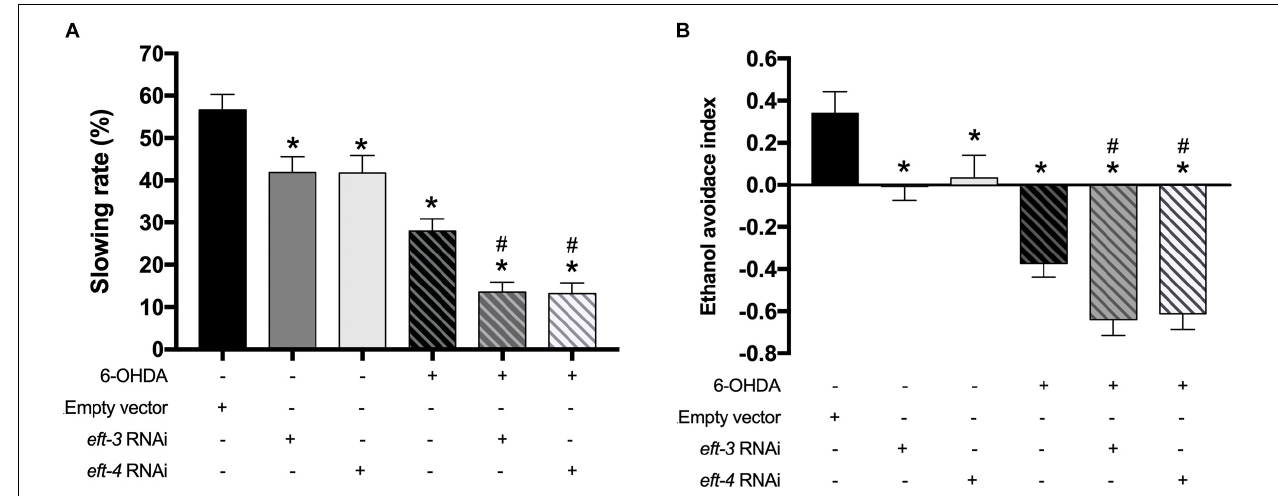
FIGURE 3 | Effects of eft-3 / eft-4 RNA interference (RNAi) and/or 6-hydroxydopamine (6-OHDA) exposure on dopamine-dependent behaviors. (A) Graphical representation of slowing rate of body bending and (B) ethanol avoidance index in the UA202 strain. The asterisk (*) indicates a significant difference between the empty vector (EV) RNAi-treated and eft-3/eft-4 RNAi and/or 6-OHDA-treated worms ( p < 0.05). The hash (#) indicates a significant difference between only 6-OHDA-treated and the combined 6-OHDA with eft-3 or eft-4 RNAi-treated worms ( p <